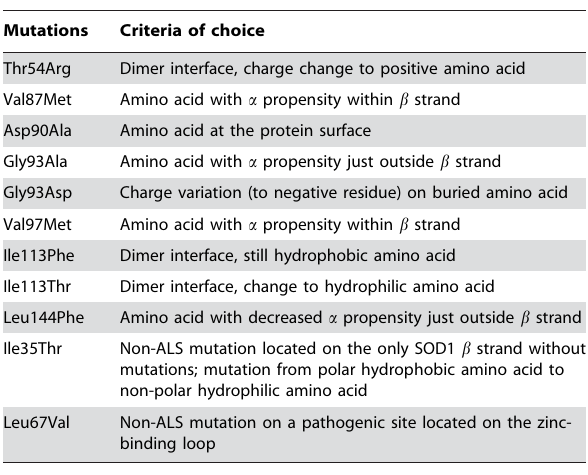
Table 1. Mutants studied in this work and their criteria of